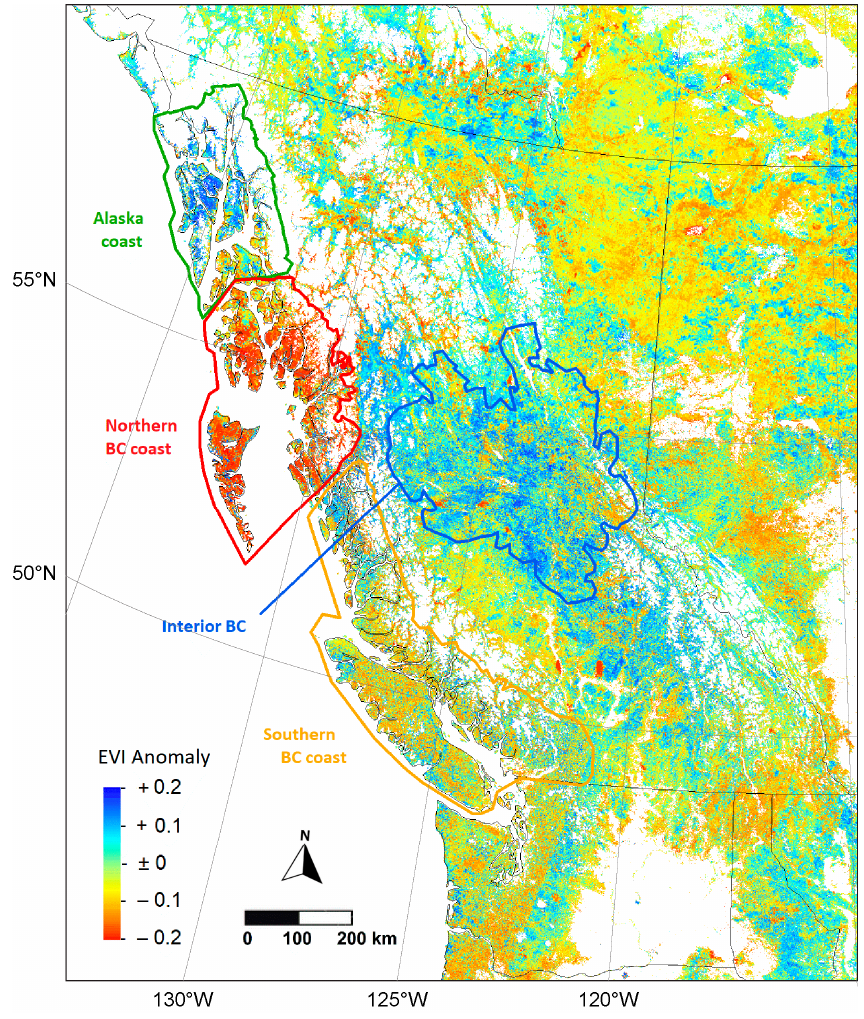
Figure 2. EVI anomalies for forested landcover in the 16-day time interval following the heat wave. Regions of similar vegetation response, subsequently used for numerical analysis, are highlighted with colored polygons, manually delineated based on regional response patterns for time series analysis of coastal and interior ecosystems (Figure 3).